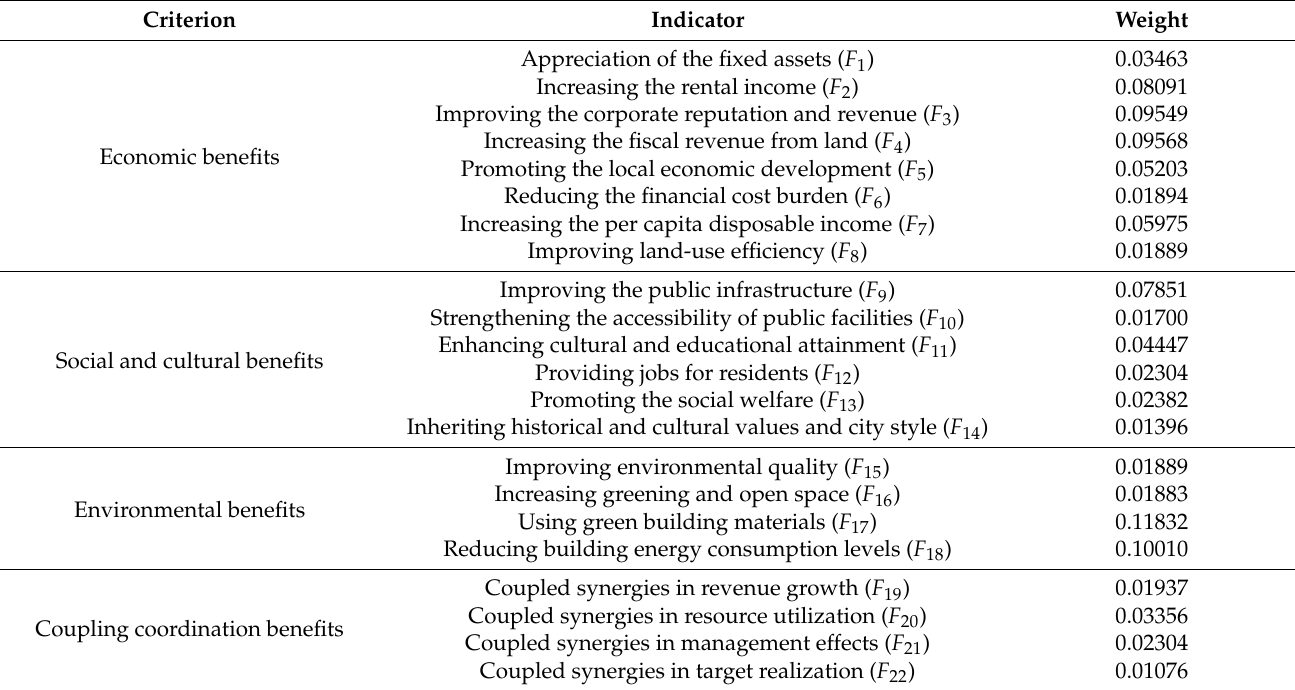
Table 2. The initial weights of each indicator.